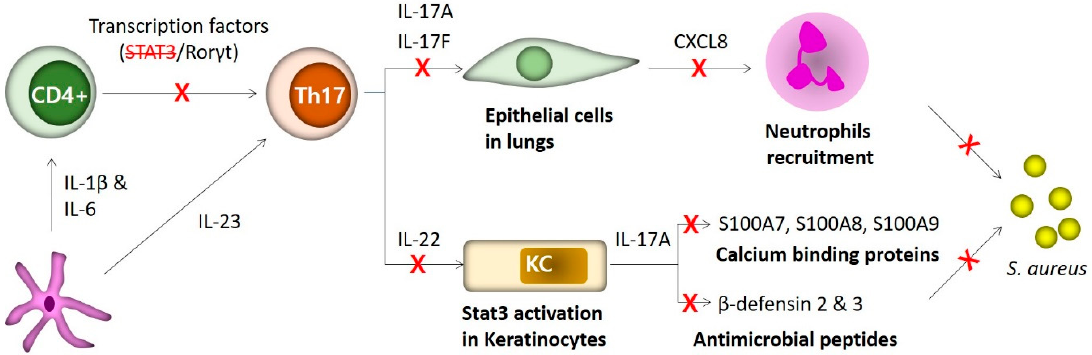
Figure 2. In HIES patients, STAT3 mutations cause defects in T H 17 cell differentiation and in host defense against S. aureus infection. In normal subjects, IL-1 β and IL-6, secreted by dendritic cells (DCs), result in the differentiation of T H 17 cells from CD4+ T cells through activating its transcription factor retinoic acid-related ROR γ t in STAT3-dependent way. Then, in presence of IL-23, T H 17 cells secrete IL-17A and IL17F stimulating epithelial cells in lungs for production of chemokines such as CXCL8 to recruit polymorphonuclear leukocytes (PMNs) for phagocytic killing of S. aureus . IL-22 out of T H 17 cells also activates STAT3 in keratinocytes to produce β -defensins and calcium binding proteins along with IL-17A to defend against extracellular S. aureus . In HIES patients, mutations in STAT3 result in failure of T H 17 differentiation, which in turn leads to the inability of epithelial cells to produce CXCL8 for recruitment of neutrophils and of keratinocytes to trigger production of β - defensins and calcium binding proteins to kill S. aureus .